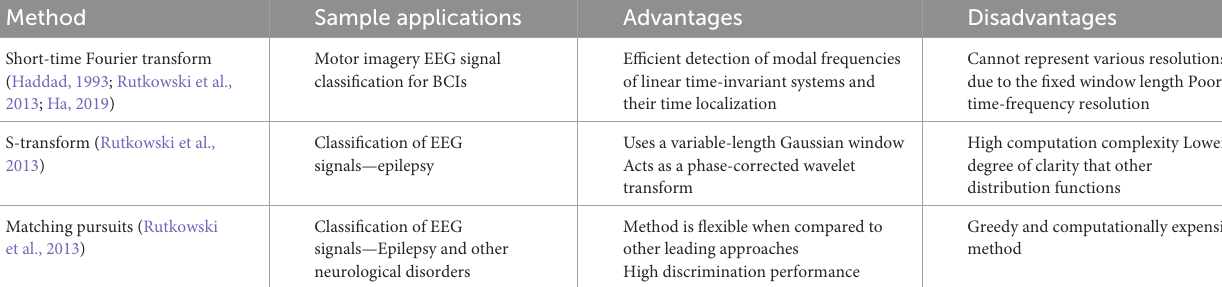
TABLE 4 Summary of time-frequency domain feature extraction methods for EEG.